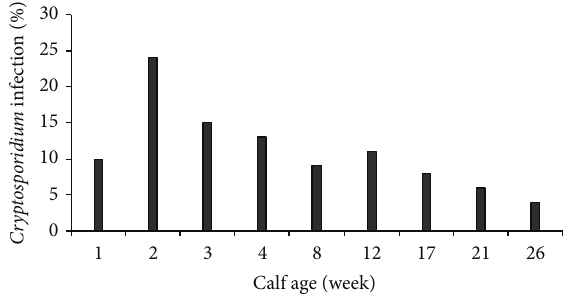
Figure 1: Distribution of Cryptosporidium infection in various age groups of